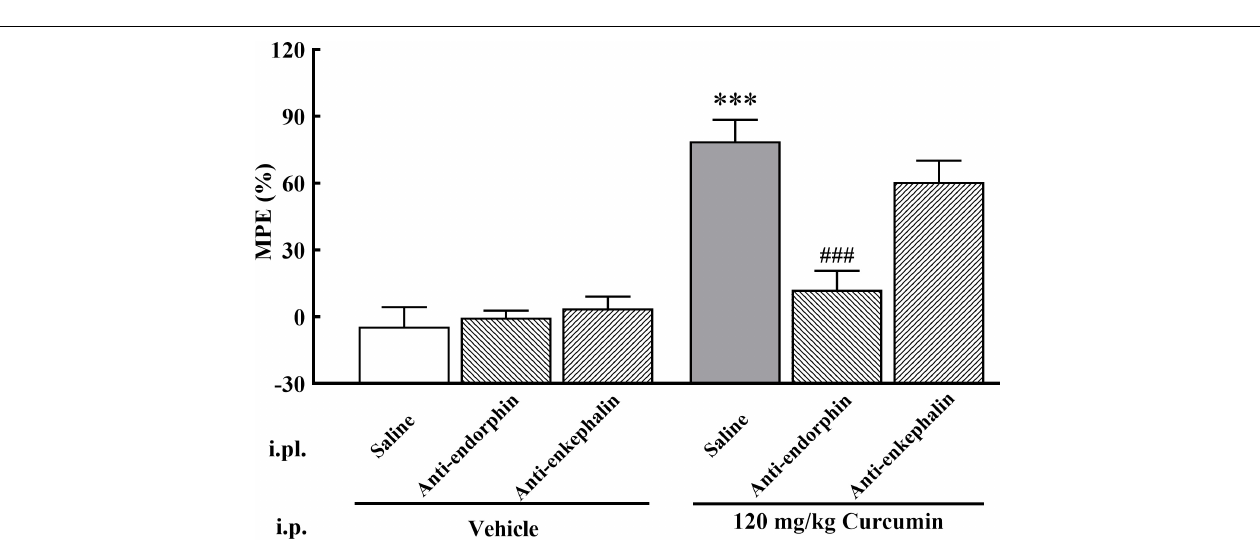
FIGURE 4 | Effect of curcumin on the release of β -endorphin and enkephalin in primary DRG neurons. The culture medium was collected 6h after curcumin incubation with primary cells, and the release of β -endorphin and enkephalin was determined by using an ELISA kit. Curcumin at 50 µ M significantly increased the release of β -endorphin (A) and enkephalin (B) . Data are shown as means ± SEM, n = 4–11. * P < 0.05 and *** P < 0.001 compared with the vehicle group, t -test.